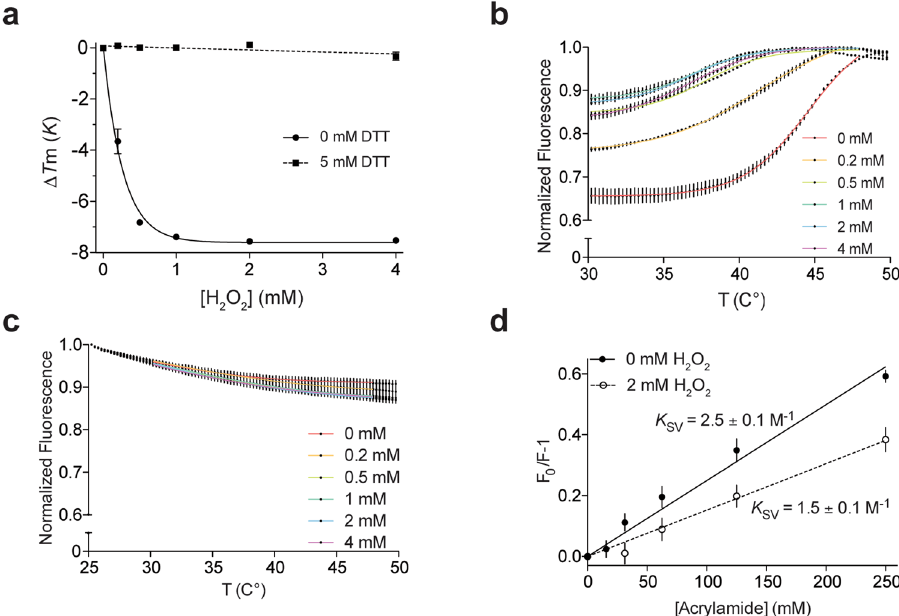
Figure 6. mCLIC6 response to oxidative environment. ( a ) The effect of H 2 O 2 on mCLIC6, measured using differential scanning fluorimetry in the presence or absence of 5 mM DTT, and presented as T m difference. ( b ) Normalized fluorescence-temperature relation of mCLIC6 in the presence of increasing concentrations of H 2 O 2 . Boltzmann fits used to calculate T m are colored according to H 2 O 2 concentrations. ( c ) Normalized fluorescence-temperature relation of mCLIC6-Q383A in the presence of increasing concentrations of H 2 O 2 . ( d ) Stern–Volmer plots for mCLIC6 tryptophan fluorescence quenching by acrylamide in both the absence and presence of H 2 O 2 .